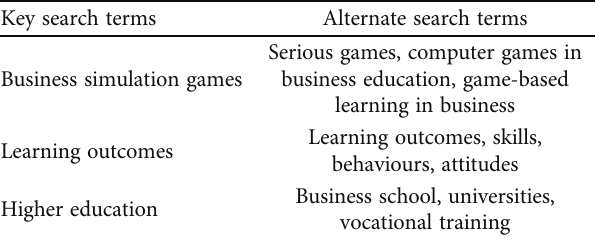
Table 2: Terms used in the paper search.